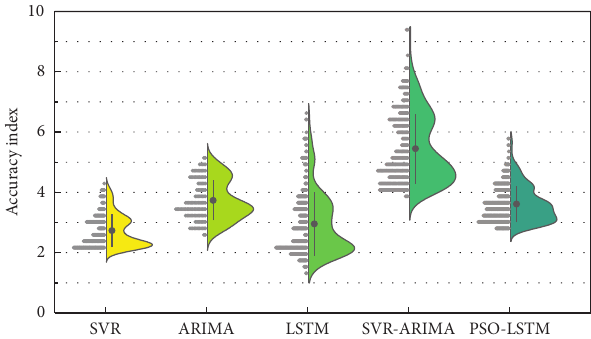
Figure 7: Comparative analysis of model prediction effects.